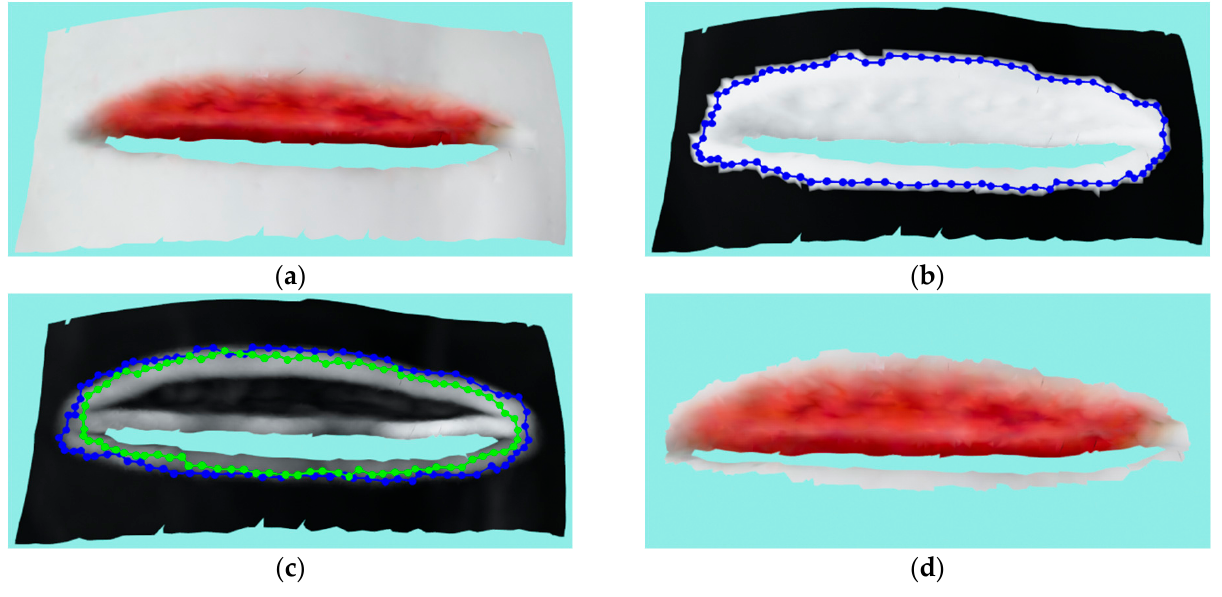
Figure 17. Case study for 5 ½ inch long dehisced surgical wound: ( a ) input wound mesh; ( b ) masked wound mesh with initial contour; ( c ) wound mesh with curvature texture and initial and final contours shown in blue and green colors, respectively; ( d ) final cut wound mesh model.